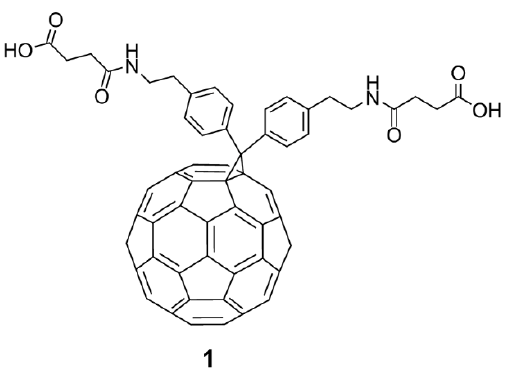
Figure 2. The first example of a water-soluble fullerene derivative ( 1 ) used as a virus inhibitor.